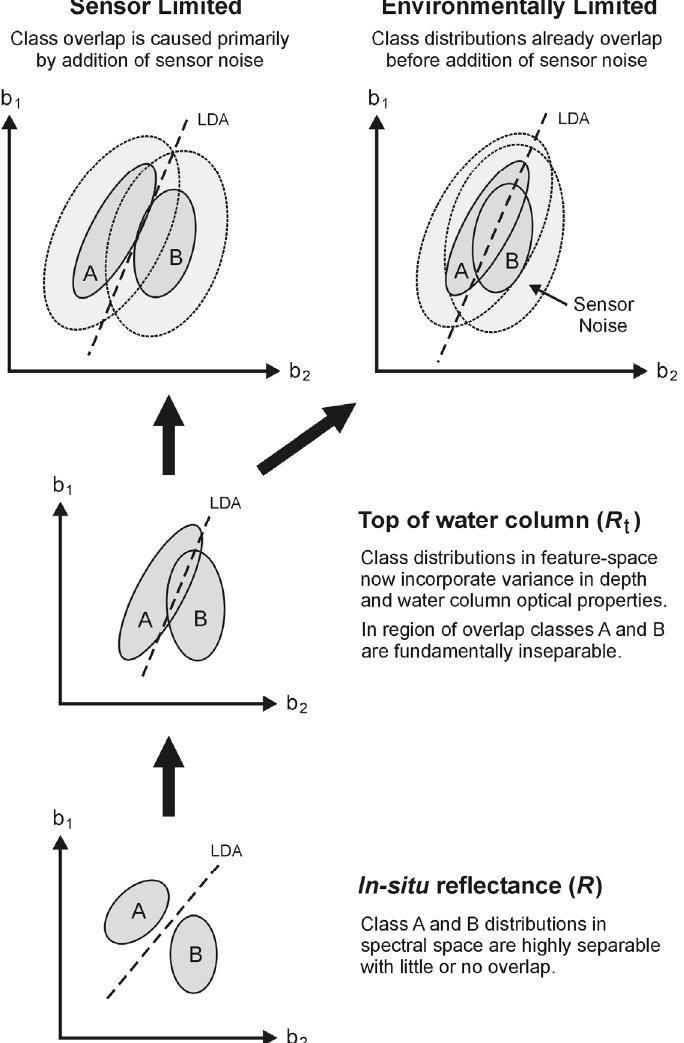
Figure 1. Sensor-limited vs. environmentally limited remote sensing. At each stage of the remote sensing system the variation in classes to be discriminated is expressed by the distribution of their member populations in spectral space, e.g., as illustrated in two bands b1, b2. The extent of overlap between two classes expresses their fundamental inseparability. Variation in different components of the system, such as benthic class spectral variation, variance in water clarity, or sensor noise, contributes to overall variation in the recorded signal. Sensor-limited objectives are those for which a change in sensor design characteristics will improve separability despite environmental sources of